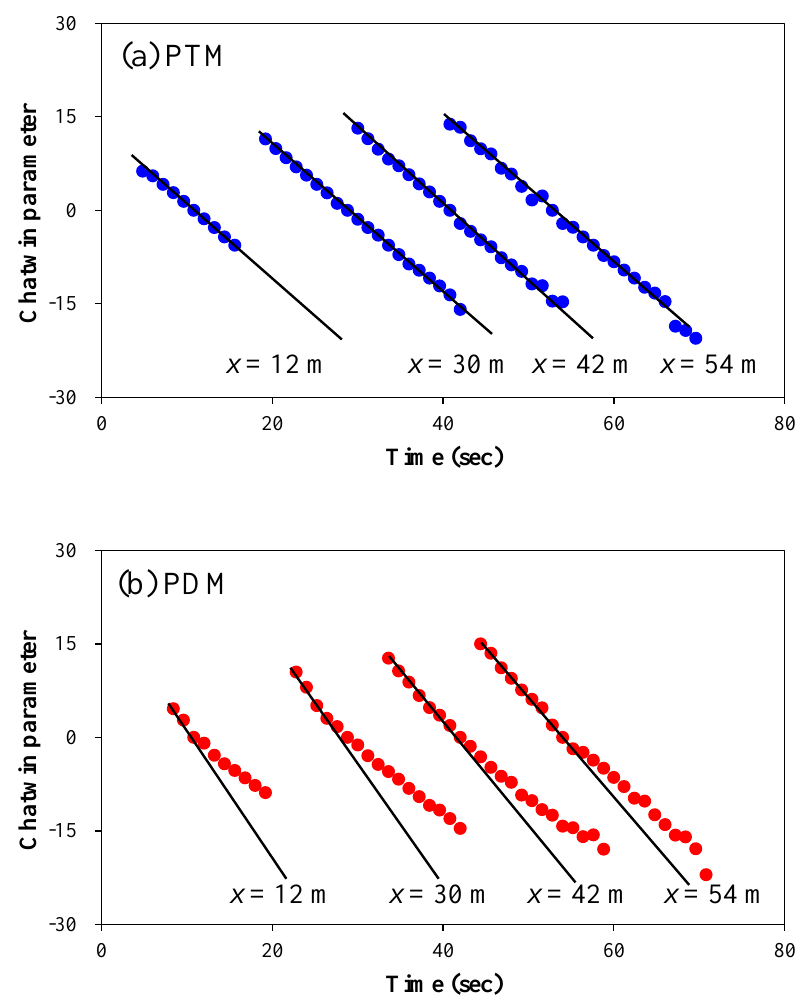
Figure 5. Time evolution of Chatwin’s parameter for C – t curves at the center of the channel.